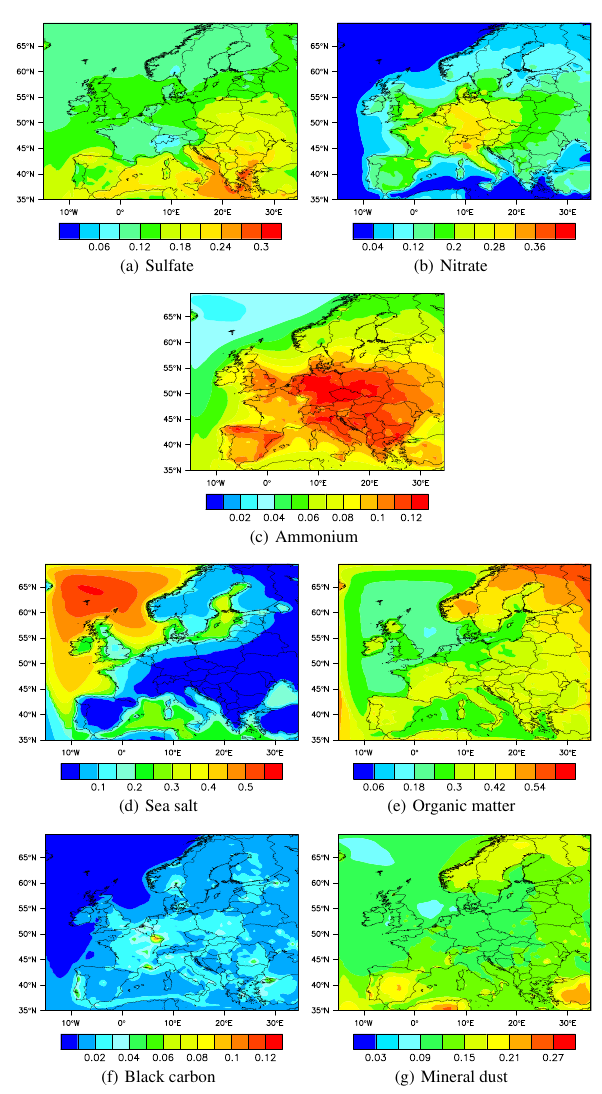
Fig. 3. Nine-year (2000–2008) averaged surface fractions of sul- fate, nitrate, ammonium, sea salt, organic matter, black carbon, and mineral dust in PM 2 . 5